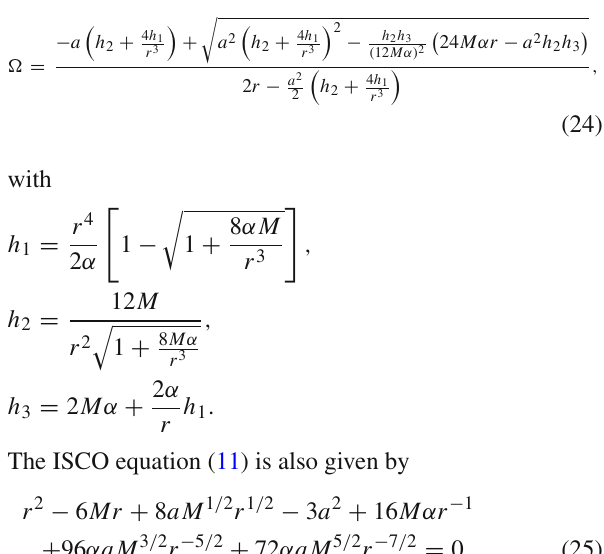
Fig. 1 The behavior of horizons as a function of the radial coordinate r for different values of the GB coupling parameter α with a = 0 . 1 (top-left panel), a = 0 . 2 (top-right panel), a = 0 . 3 (bottom-left panel)